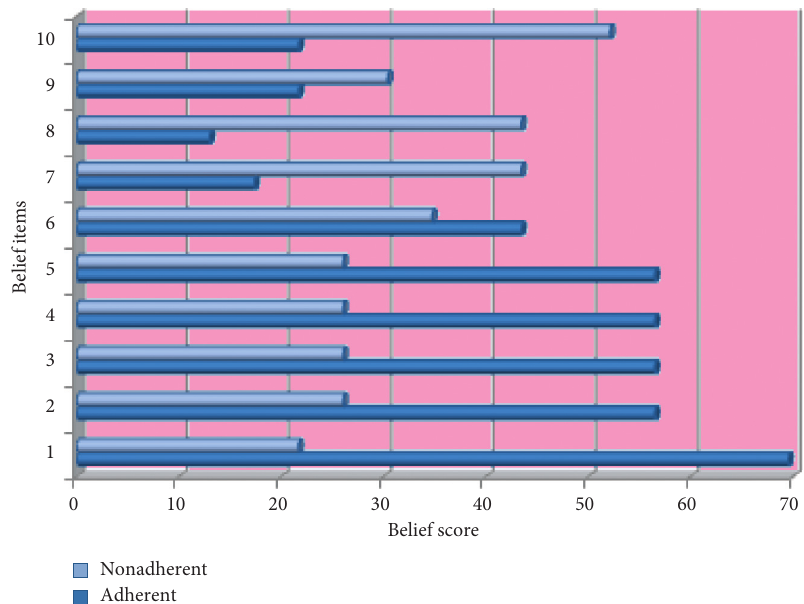
Figure 2: Distribution of belief items by adherent and nonadherent elderly subjects with epilepsy. The items include my health at present depends on my ASMs, my life would be impossible without my ASMs, without my ASMs, I would become very ill, my health in the future will depend on my ASMs, and my ASMs protect me from becoming worse, having to take ASMs worries me, I sometimes worry about the long-term effects of my ASMs, my ASMs are a mystery to me, my ASMs disrupt my life, and I sometimes worry about becoming too dependent on my ASMs.